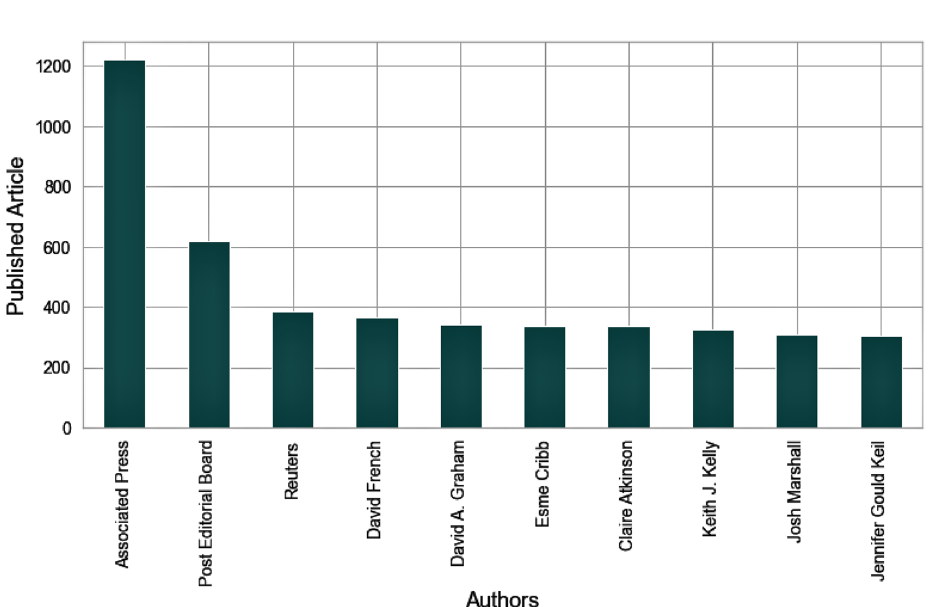
Figure 4. Top 10 authors in article2